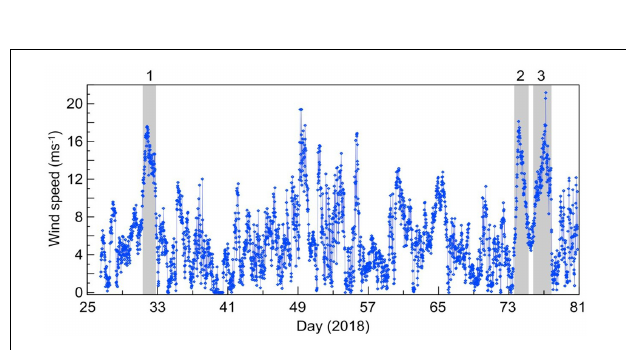
FIGURE 6 | Wind speed during the study period with highlighted maximum wind speed events described more in